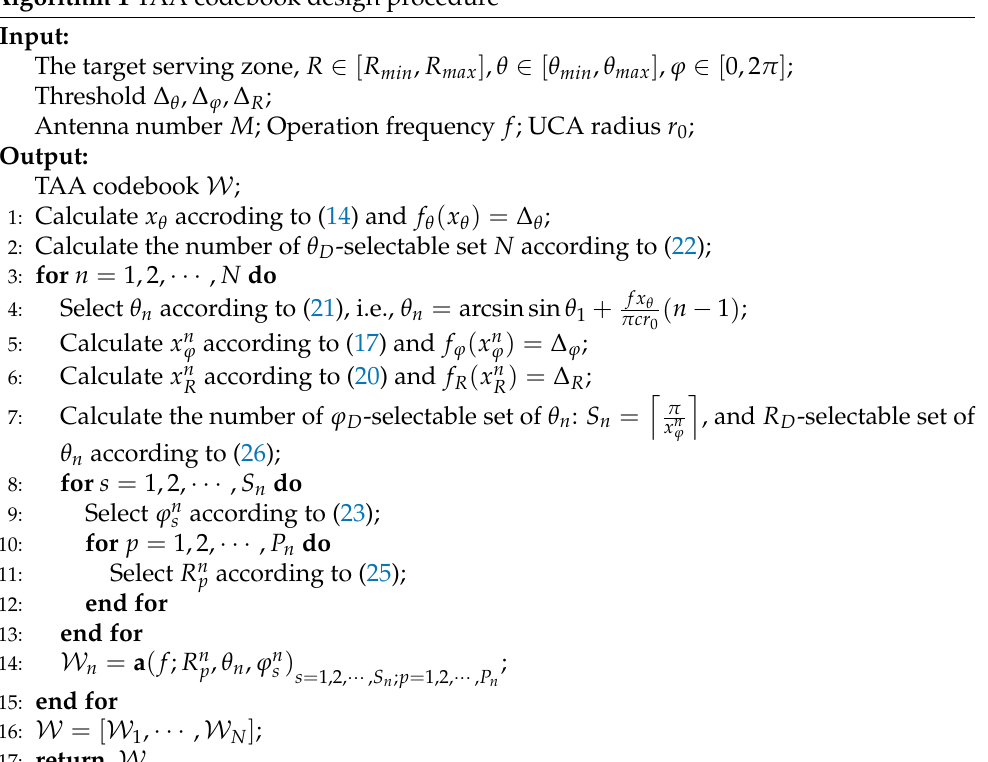
Algorithm 1 TAA codebook design